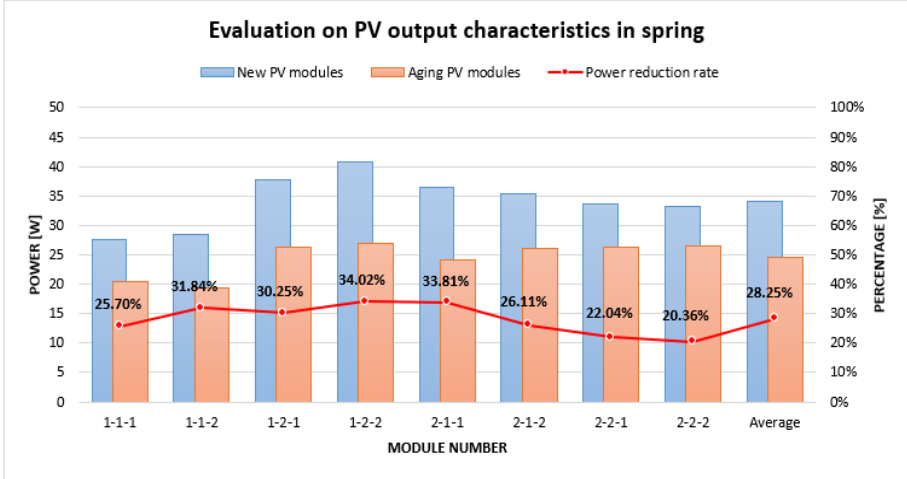
Figure 7. Output characteristics between new and aged PV modules in spring.